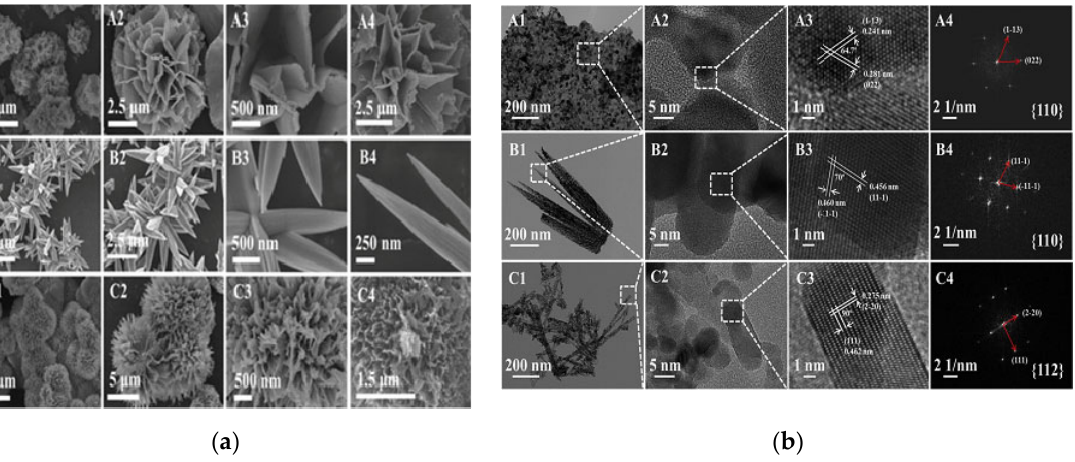
Figure 7. ( a ) SEM images of (A1–A3) H, (B1–B3) S, and (C1–C3) P before calcination and (A4), (B4), and (C4) after calcination at 350 °C. ( b ) TEM, HRTEM, and fast ‐ Fourier ‐ transform (FFT) images of the Co 3 O 4 samples: (A1–A4) H, (B1–B4) S, and (C1–C4) P. Reprinted with permission from Ref. [77].